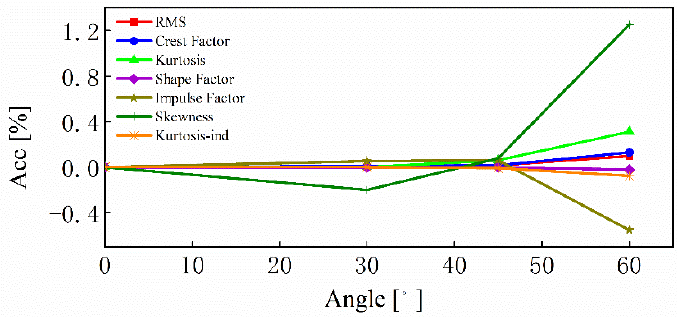
Figure 22. Change of percentage of statistical index with different crack angles.